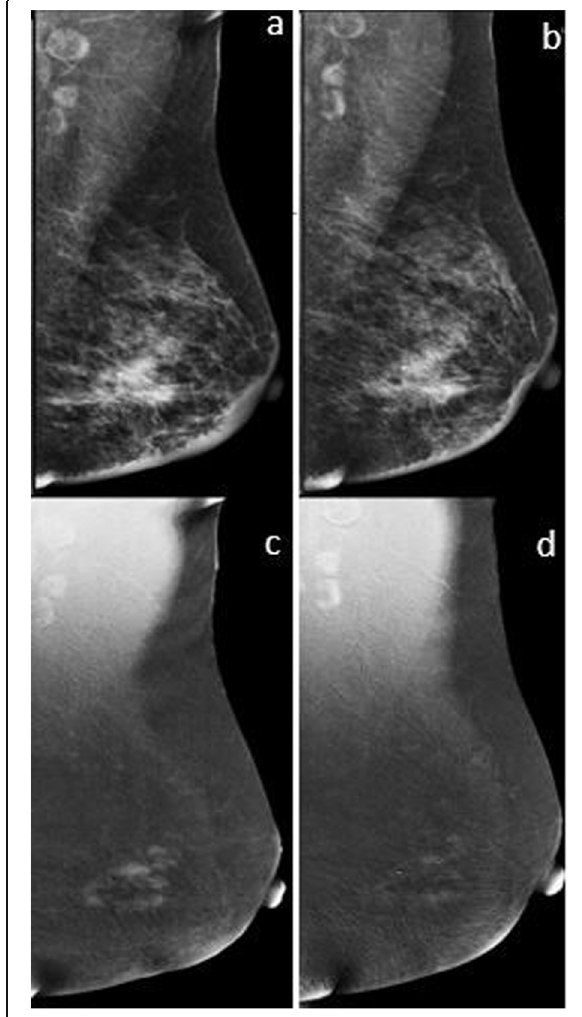
Fig. 6 a Pre-NAC mammogram; spiculated LOQ mass. b Post-NAC mammogram; marked reduction in size. c Pre-NAC CESM; separated lesions. d Post-NAC CESM CC view showing no residual enhancing lesions. CESM classified this patient as a complete